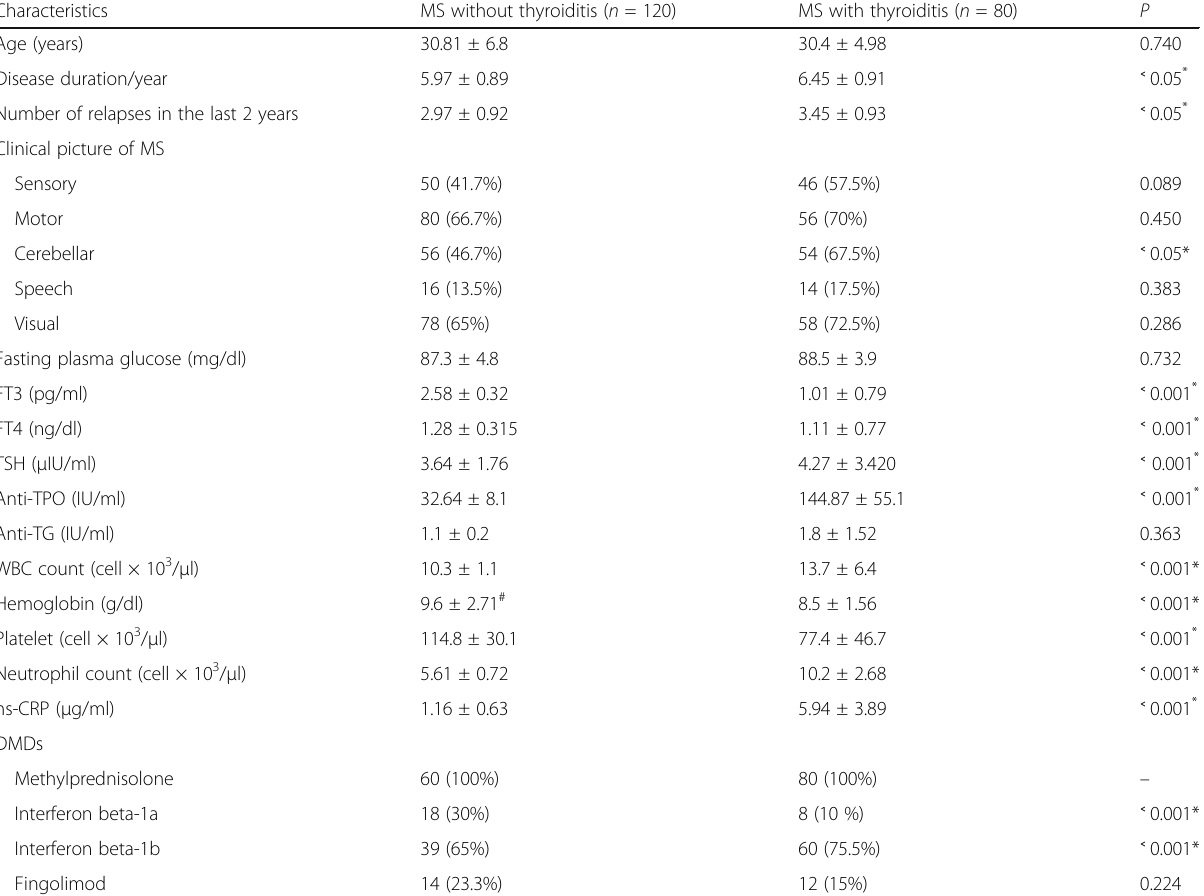
Table 1 Clinical and laboratory characteristics of patients with MS